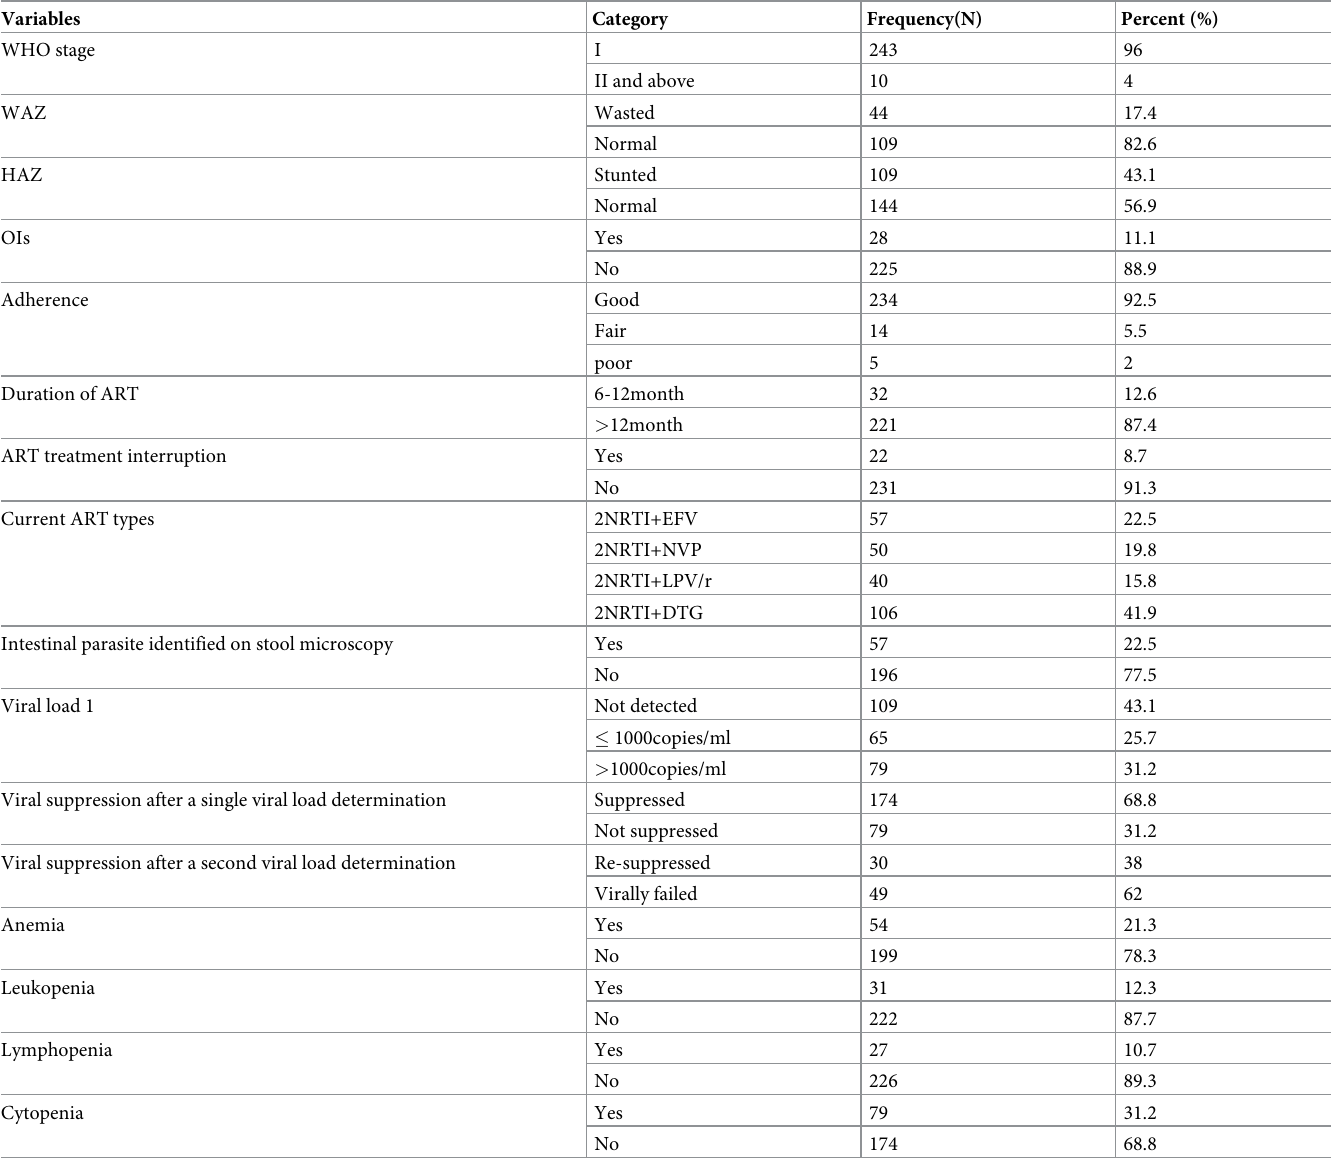
Table 2. Clinical characteristics and laboratory findings of the study participants attending at UoGCSH, Northwest Ethiopia, 2021.